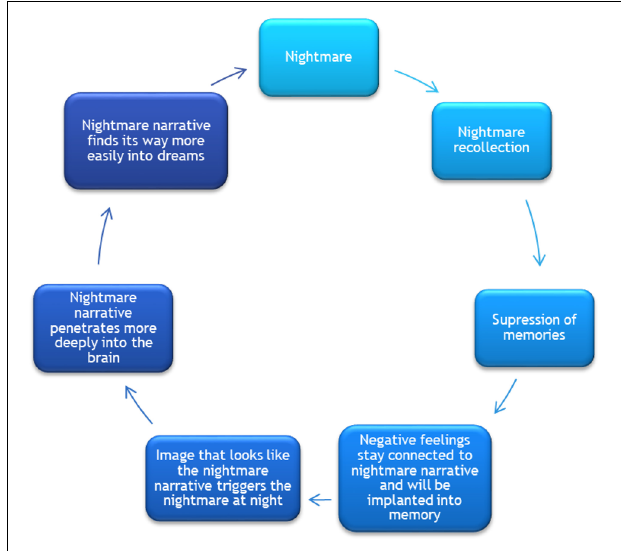
FIGURE 1 | Vicious circle of nightmares. Adapted and translated from Imaginatie-en rescriptingtherapie voor nachtmerries (p. 15) by Van Schagen et al. (2012), Bohn Stafleu van Loghum. Copyright 2012, Bohn Stafleu van Loghum Publishing. Reprinted with